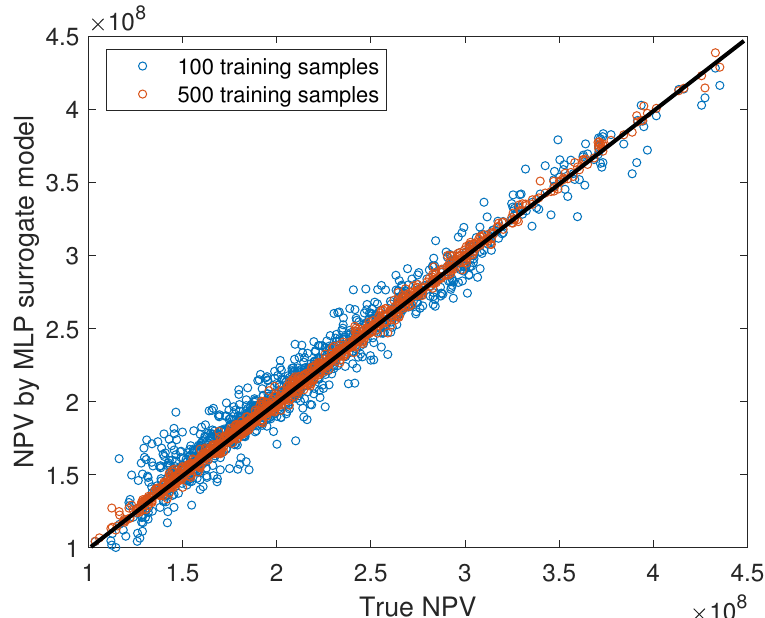
Figure 12. The crossplot results between true values and surrogate-based values. The MLP surrogate models are trained by 100 samples and 500 samples,